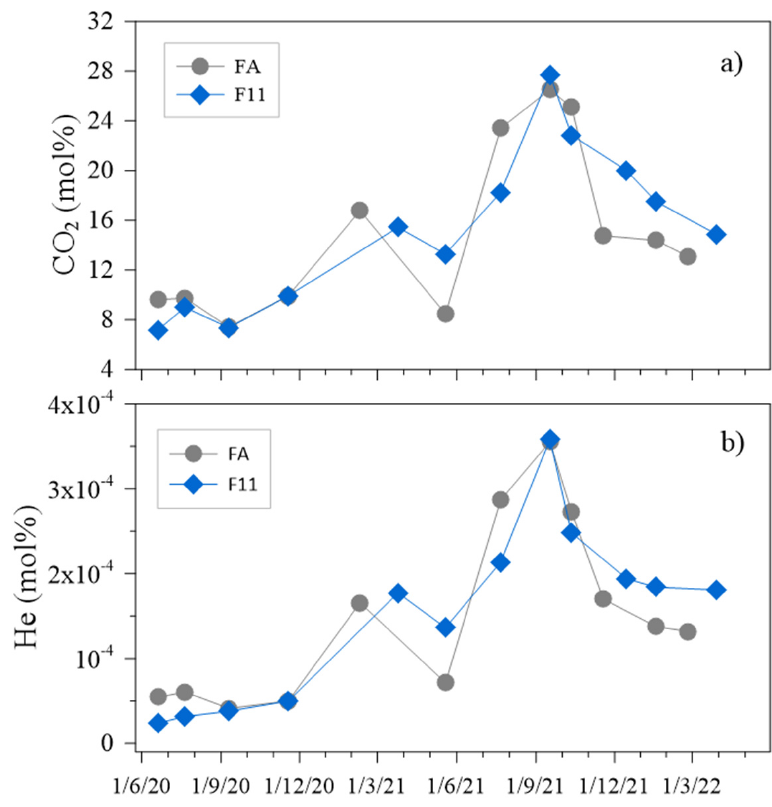
Figure 3. Time trends of ( a ) CO 2 and ( b ) He in the vapor of fumaroles FA and F11. Total sulfur contents, although not coherent in all the fumaroles, showed a global increase since the sampling campaign of 14 September 2021, peaking in October and then progressively decreasing (Figure 4).